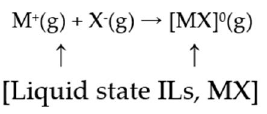
Scheme 1. Thermodynamic cycle for calculating Δ A H m0 .